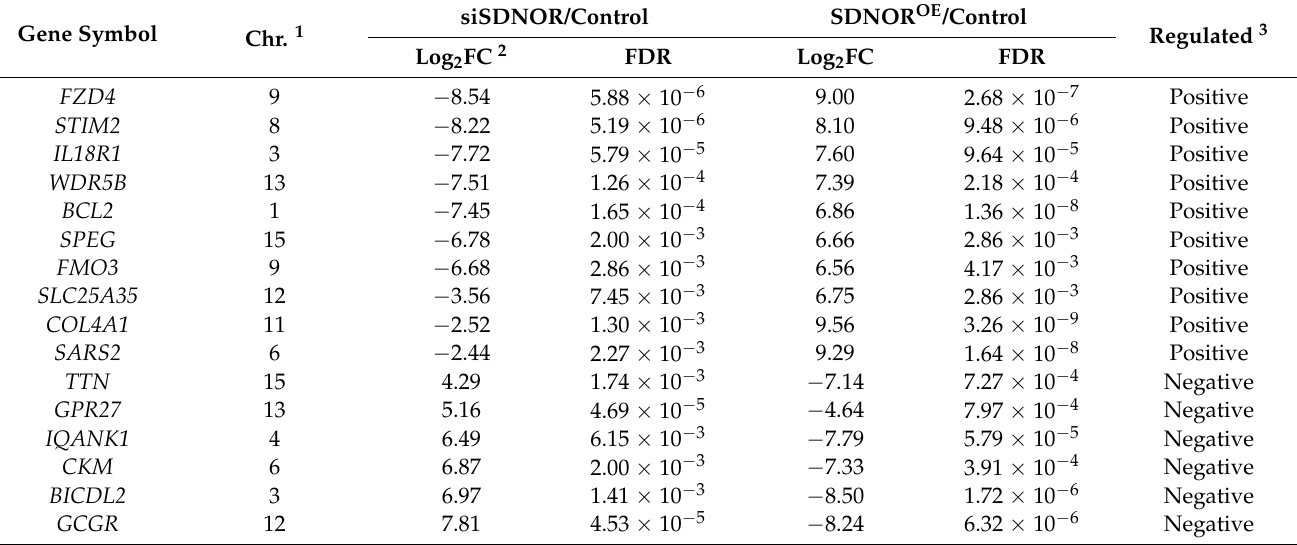
Figure 2. Validation of the accuracy of RNA-seq data. ( A – C ) The expression patterns of 4 SDNOR knockdown-sensitive DEmRNAs ( A ), 4 SDNOR-regulated DEmRNAs ( B ), and 4 SDNOR overexpression-sensitive DEmRNAs ( C ) in porcine GCs treated with siSDNOR or SDNOR OE were validated by RT-qPCR assays. Data are shown as mean ± S.E.M. with three independent replicates, and the significance was calculated by a two-tailed Student’s t -test. * p < 0.05, ** p < 0.01. Table 1. Top 20 SDNOR-regulated DEmRNAs in porcine